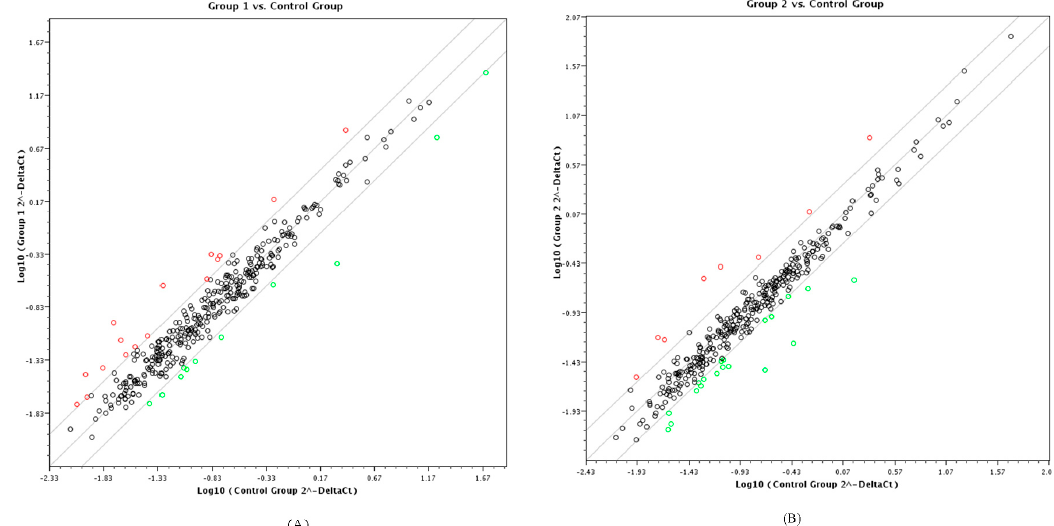
Figure 1. Scatter plot of differentially expressed miRNAs generated from QIAGEN web-based polymerase chain reaction (PCR)-array data analysis software. Group 1 represents human immunodeficiency virus (IV)-1 infected peripheral blood mononuclear cells (PBMC), Group 2 represents HIV-2 infected PBMC and control group represents mock infected (no virus) PBMC. Plot shows the microRNA (miRNA) expression in ( A ) HIV-1 infected PBMC vs . control PBMC and ( B ) HIV-2 infected PBMC vs . control PBMC. Red ( o ) circles represent upregulated and green ( o ) circles represent down regulated miRNAs with an expression level of greater than 2 fold upregultaion or downregulation